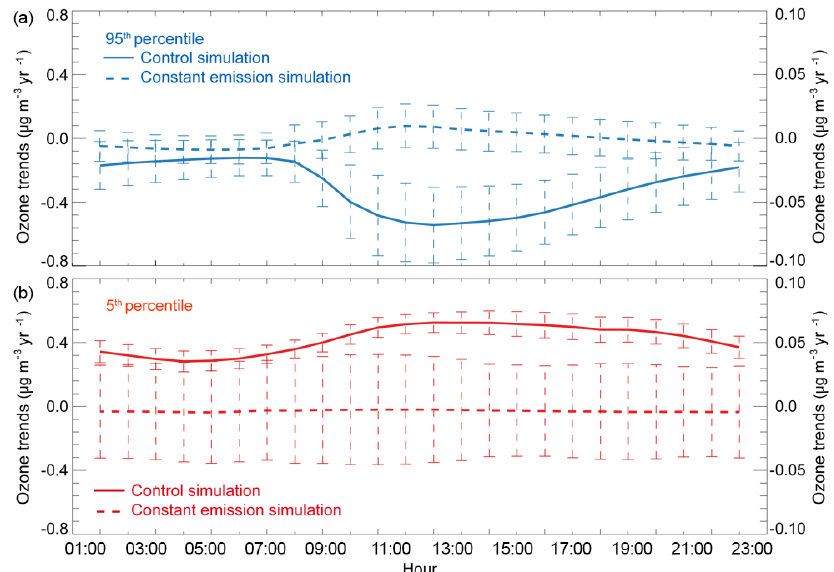
Figure 8. Modeled trend in the surface ozone averaged over the selected 93 sites for all hours of the day (local time). The solid lines (left legends) show the 1995–2014 linear trends in the control simulation for 95th (a) and 5th percentile (b) ozone, respectively. The dashed lines (right legends) represent the modeled trends by the constant emission simulation. The bars indicate their